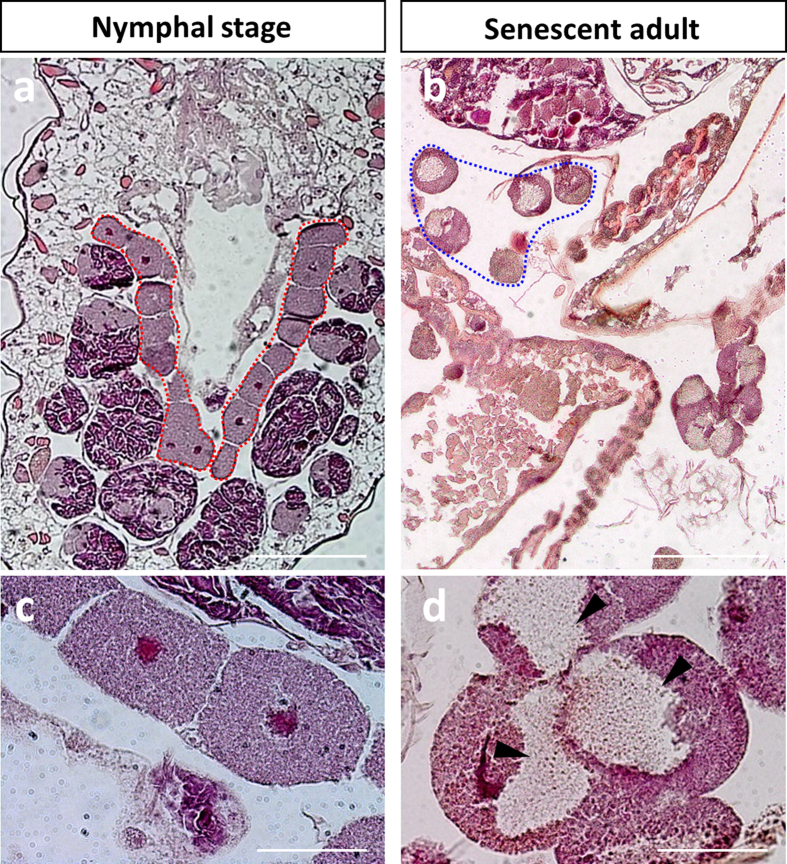
Dynamics of bacteriocyte structures during aphid aging.Comparison of hematoxylin and eosin stainings performed on parthenogenetic N3 nymph (a,c) and A23 senescent adult (b,d) sections. The top panels (a,b) show the general organization of the bacteriocyte structures in the aphid abdomen. Red and blue dotted lines outline the clustering of bacteriocytes into two regular structures surrounded by the embryonic chains, in nymphs, and the degenerating bacteriocyte structures, in senescent aphids, respectively. The bottom panels (c,d) show representative bacteriocyte cells. Arrowheads show low symbiont-density zones in degenerating bacteriocytes. Scale bars = 200 μm (a,b) or 50 μm (c,d).